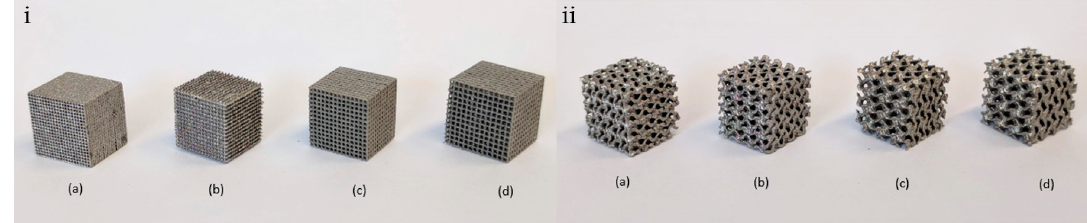
Figure 5. 3D Printed ( i ) cube and ( ii ) gyroid samples with pore size: ( a ) 0.3 mm; ( b ) 0.4 mm; ( c ) 0.5 mm; and ( d ) 0.6 mm.